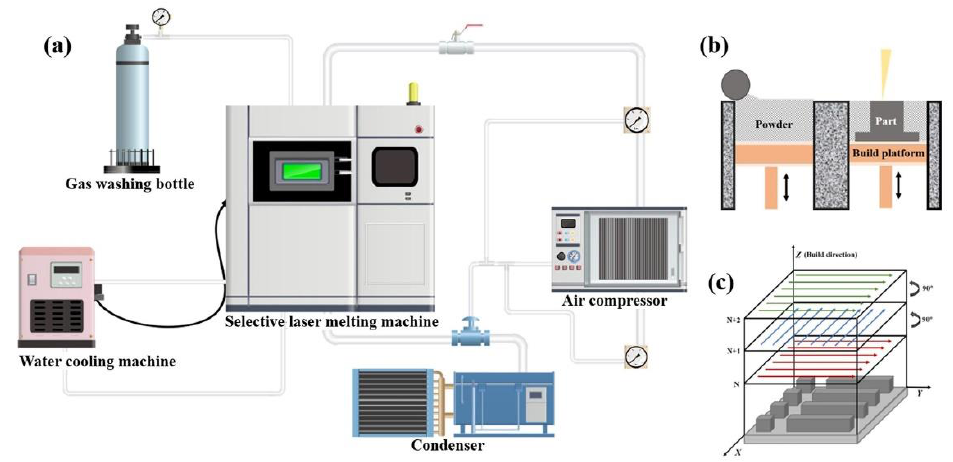
Figure 10. The basic flowchart of SLM: ( a ) Parts of the experimental apparatus, including selective laser melting machine, water-cooled machine, condenser, air compressor, and gas washing bottle; ( b ) working sketch of SLM; ( c ) print strategy of specimens [157]. (Reprinted with permission from Ref. [157]. Copyright 2022 Elsevier).